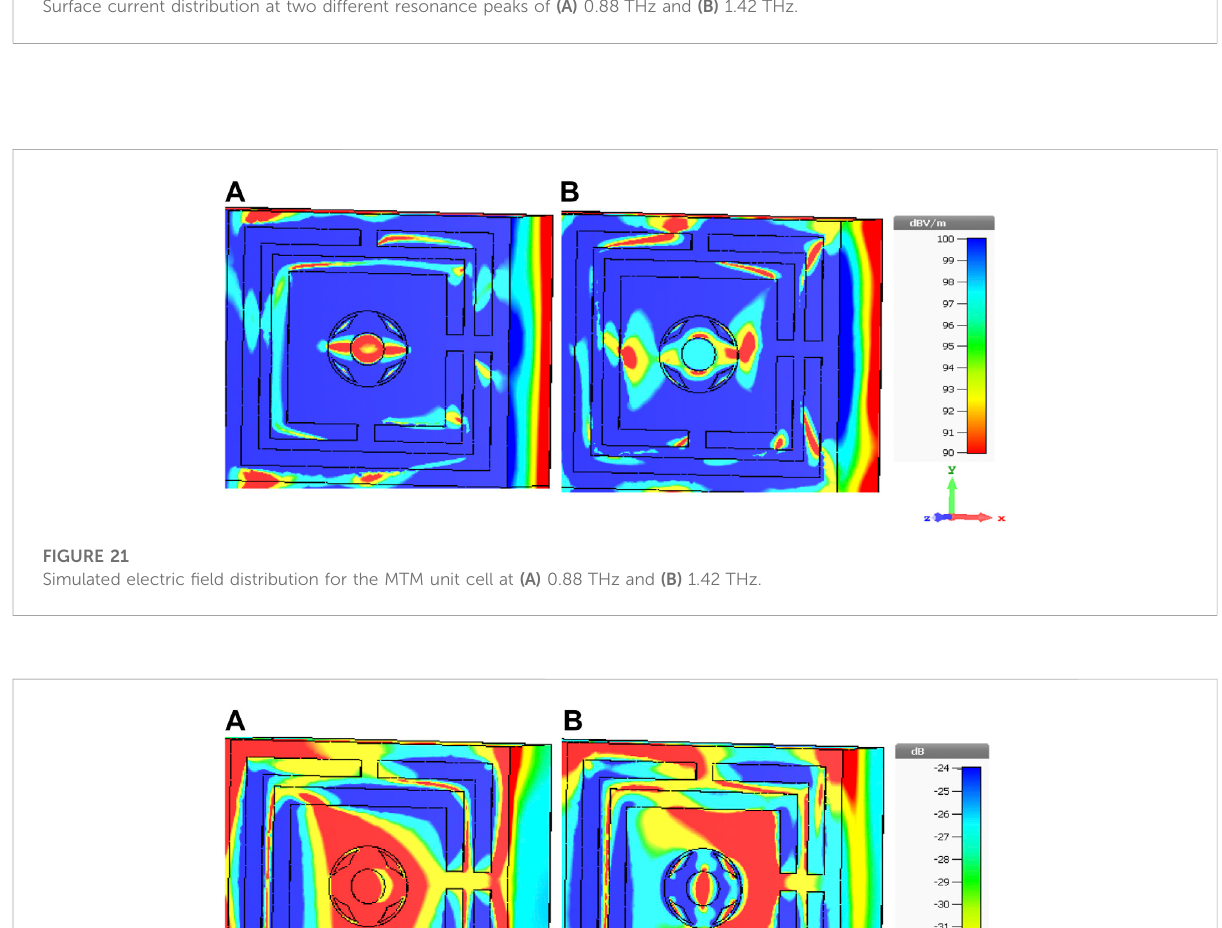
FIGURE 20 Surface current distribution at two different resonance peaks of (A) 0.88 THz and (B) 1.42 THz.